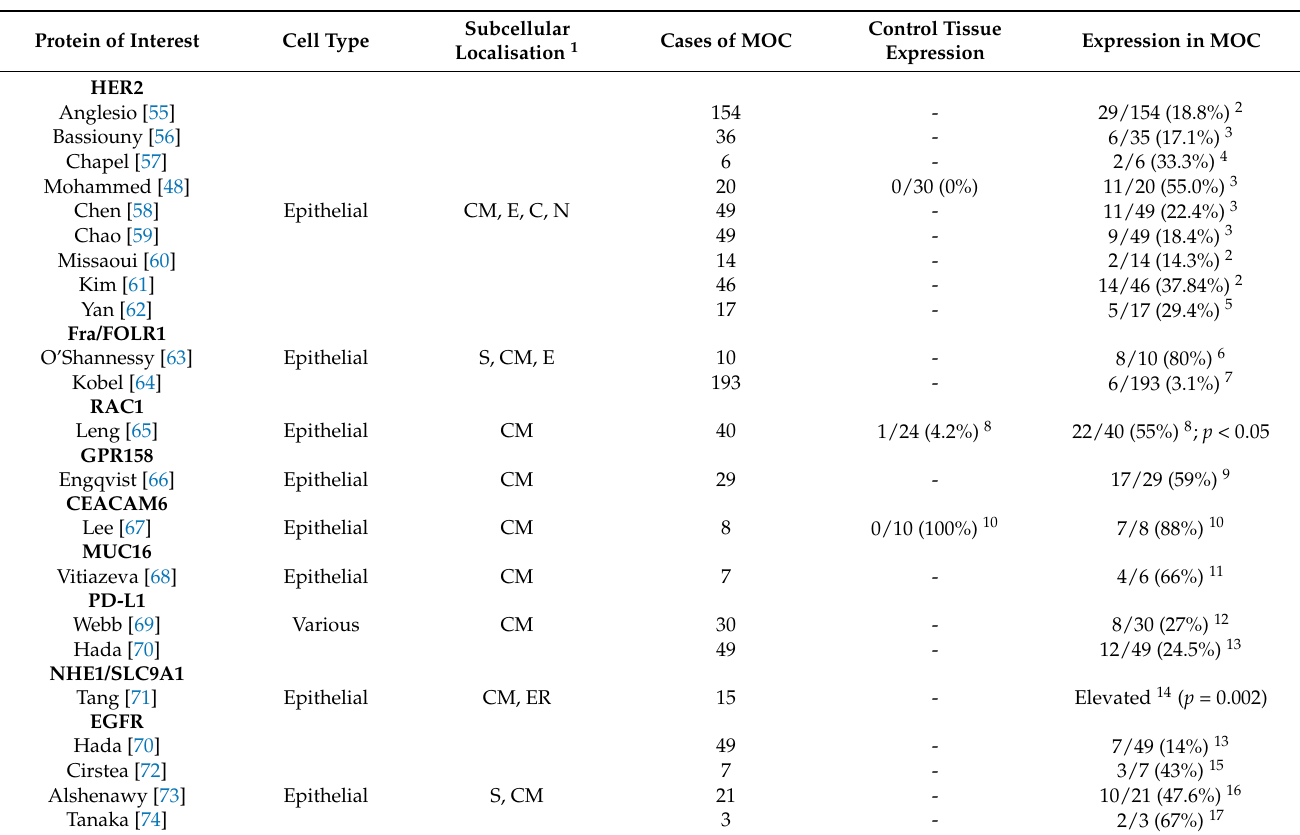
Table 1. Immunohistochemical expression profiles of selected targets in